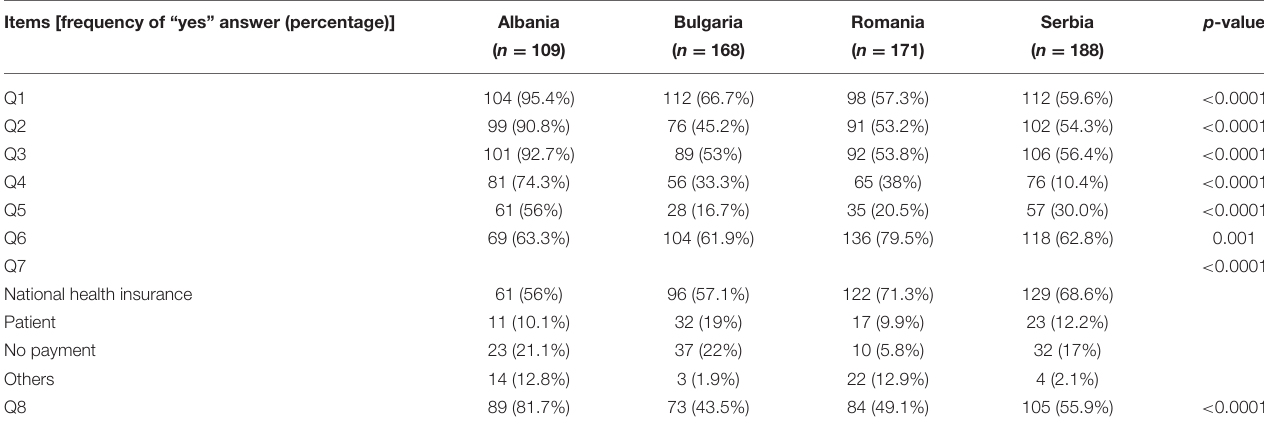
TABLE 2 | The survey results. Items [frequency of “yes” answer